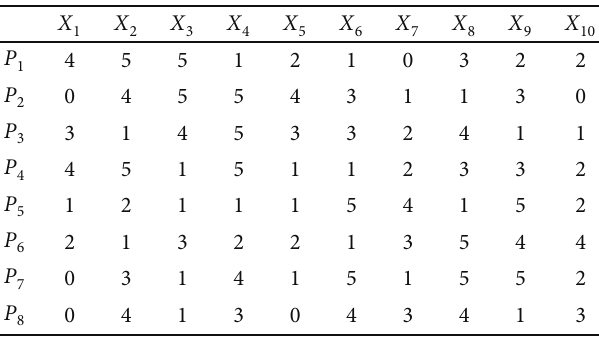
Table 2: Scoring